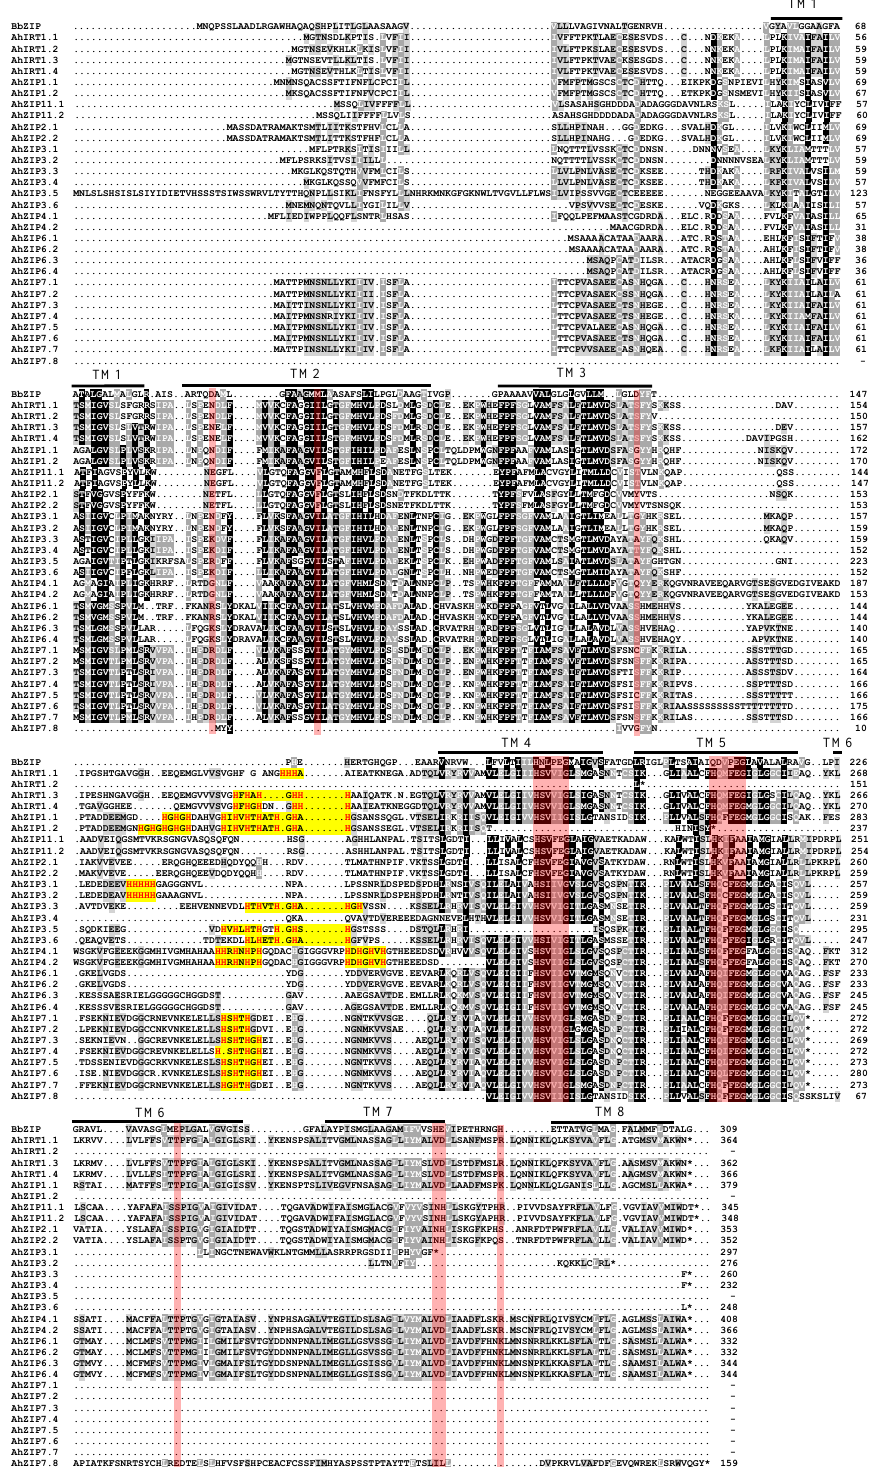
Figure 5. Multiple sequence alignment of BbZIP and AhZIP proteins. BbZIP protein from Bordetella bronchiseptica and 30 AhZIP proteins were aligned using ClustalW. The red bars indicate that amino acid residues possibly formed Zn 2+ and Cd 2+ binding sites in the BbZIP protein. The yellow high- lighted motifs indicate histidine-rich domains (HRDs) in the long cytoplasmic loop between TM3 and TM4.